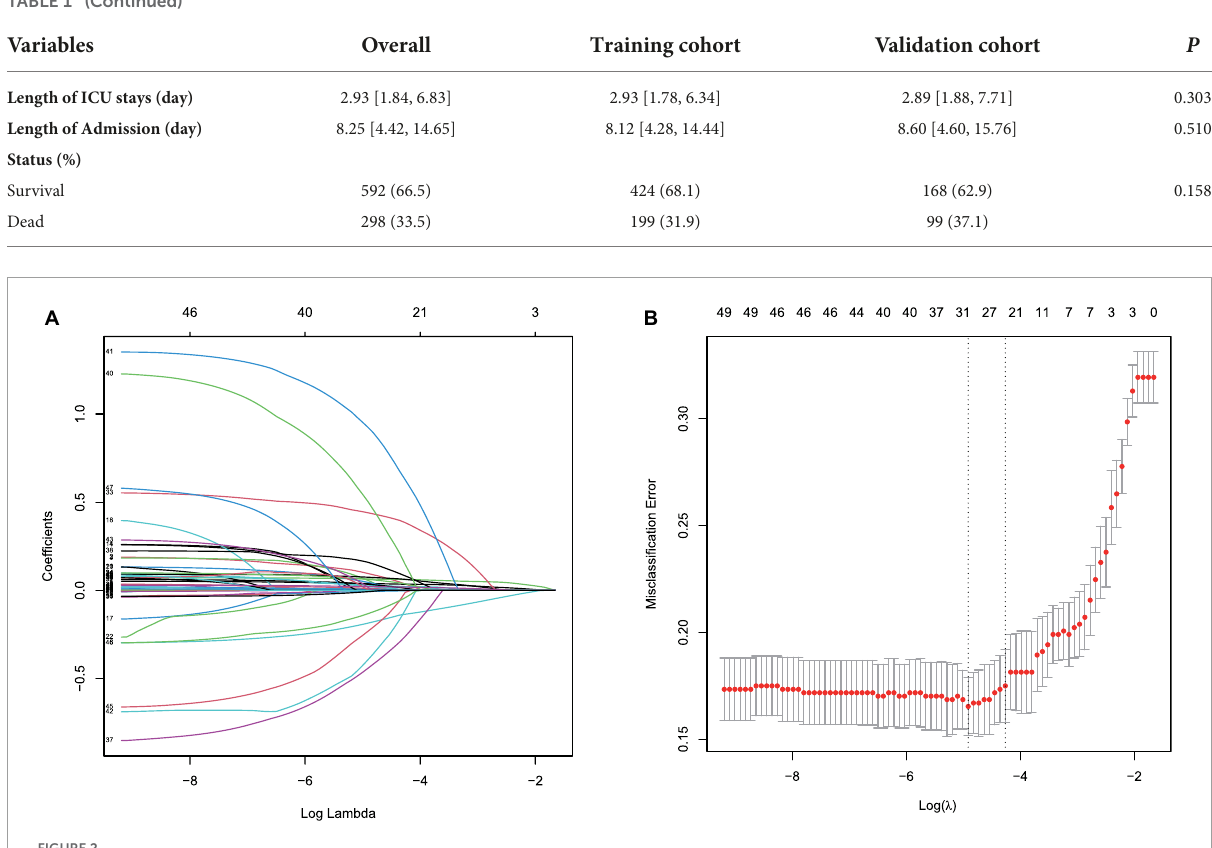
FIGURE2 Least absolute shrinkage and selection operator (LASSO) binary logistic regression model for identifying independent risk factors for mortality in patients with ICH within 30 days. (A) LASSO coefficient profiles of the radiomic features. Each colored line represents the coefficient of each feature. (B) Plot the results of cross-validation, and the red dots in the figure represent the target parameters corresponding to each lambda. The largest lambda value is chosen when the cross-validation error is within one standard error of the minimum.